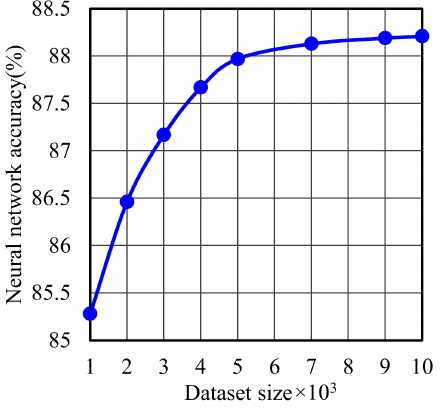
Figure 8. The accuracy of the network against the dataset size.